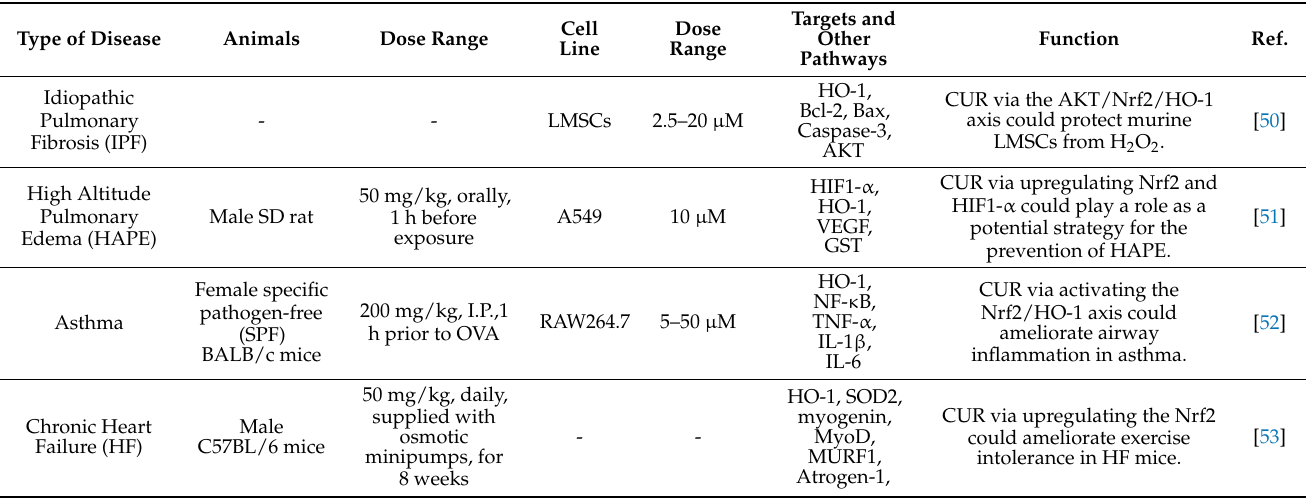
Nrf2-related therapeutic effects of curcumin in cardio/pulmonary disorders (I.P.: intraperitoneal).